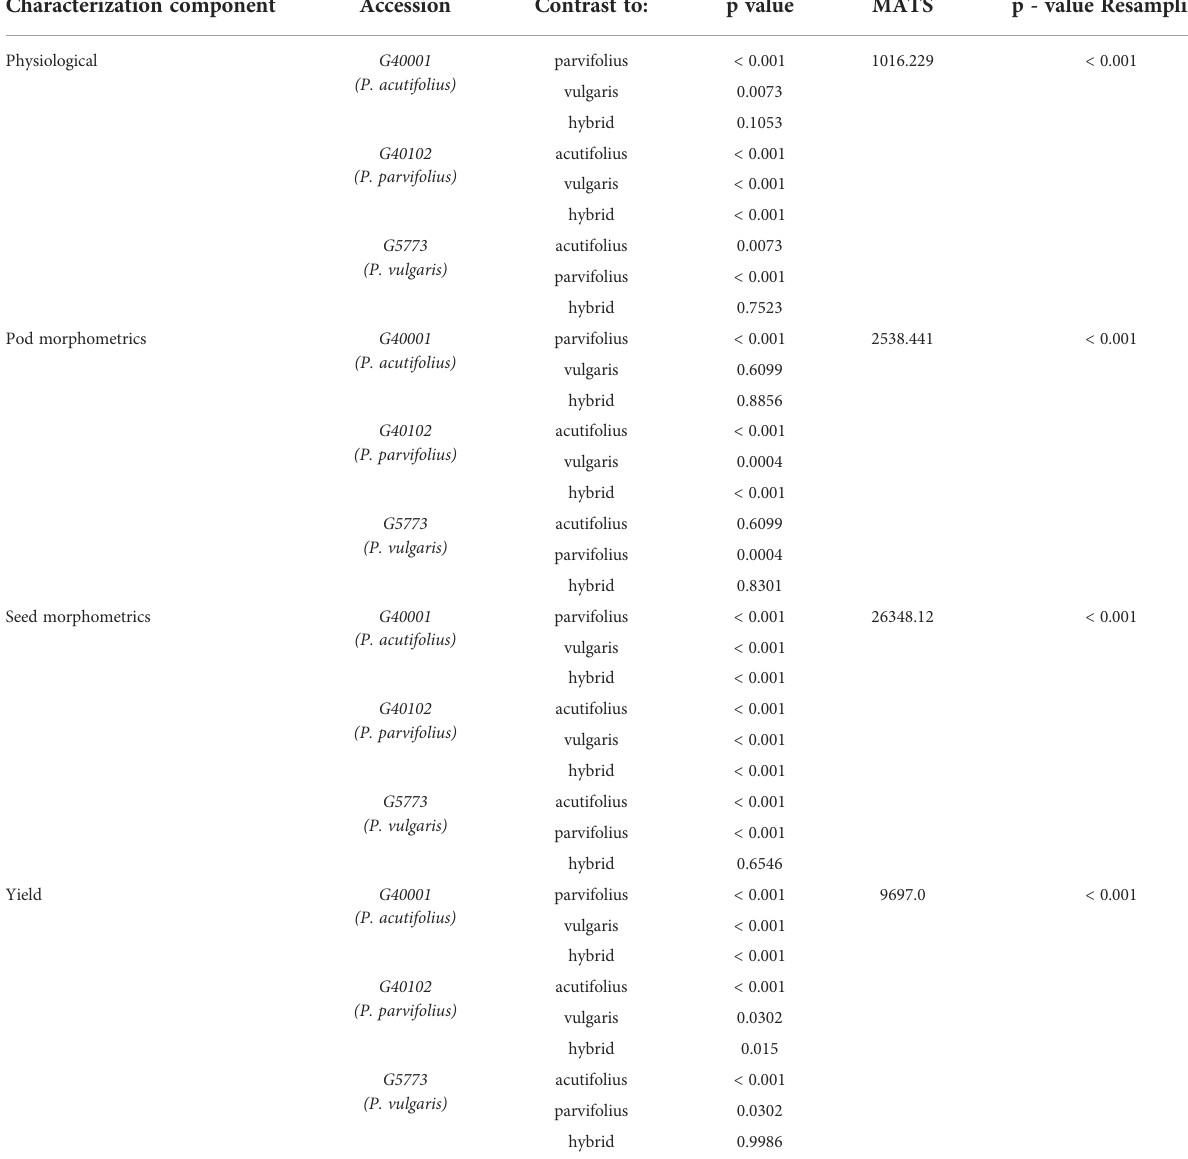
TABLE 1 MANOVA of parents and interspeci fi c hybrid in each of the characterization components. Characterization